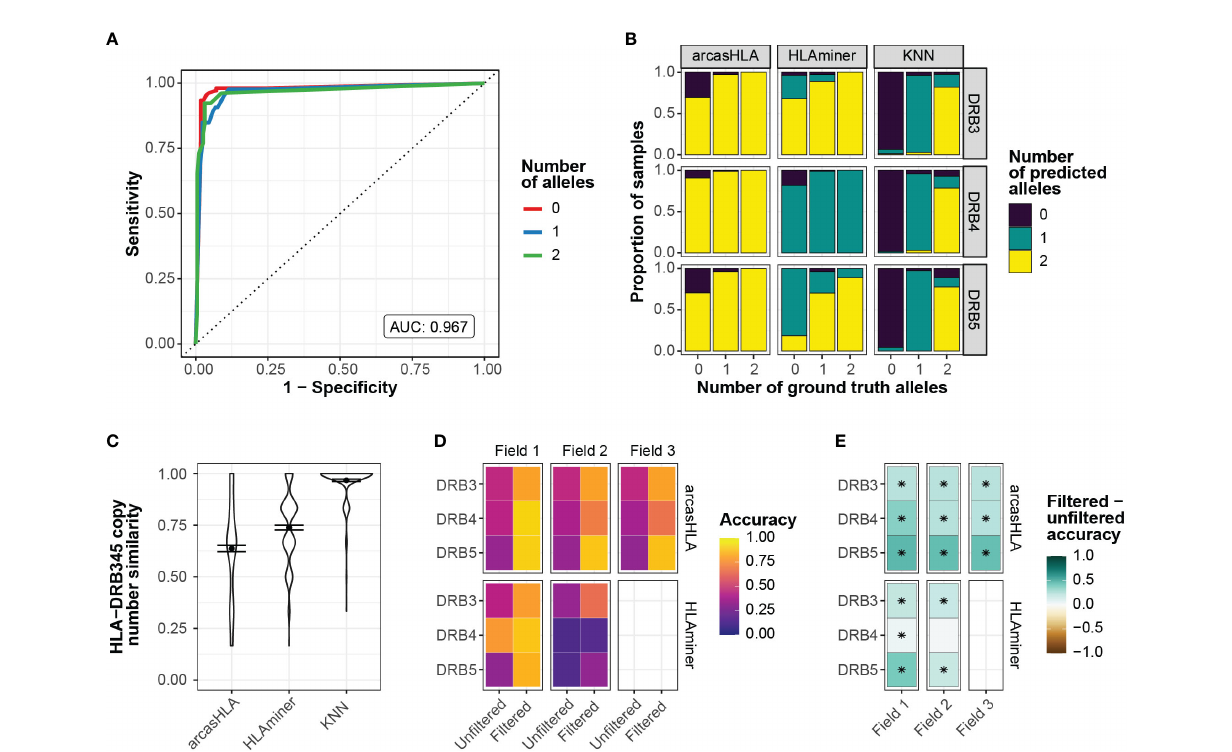
FIGURE 3 Prediction of HLA-DRB345 genotypes (A) ROC for HLA-DRB345 copy number classi fi er by kNN. Tuned on 70% test set with 10-fold cross validation. AUC represents performance on 30% hold-out test set. (B) Relative proportion of samples with ground truth HLA-DRB3, -DRB4, and -DRB5 copy numbers of 0, 1, or 2 with corresponding predicted copy numbers by arcasHLA, HLAminer, or the kNN classi fi er applied to all samples. (C) Similarity between the set of ground truth and predicted HLA-DRB3, -DRB4, and -DRB5 copy numbers for each sample. Similarity represents 1 - maximum- standardized Manhattan distance. Error bars represent standard error of the mean. (D) Mean accuracy of HLA-DRB345 genotype predictions when un fi ltered or fi ltered by kNN classi fi er. (E) Difference in fi ltered and un fi ltered mean accuracy. (*) FDR-adjusted p-value ≤ 0.05 by Wilcoxon rank sum